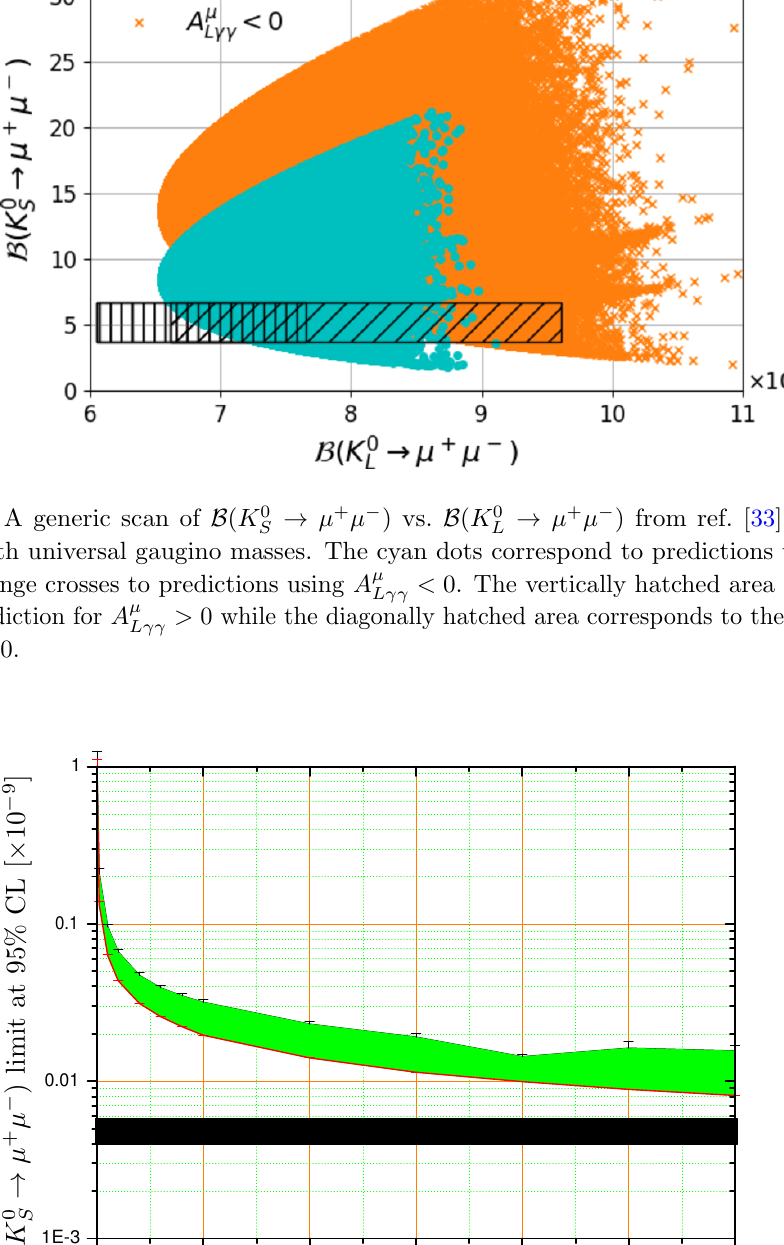
( K 0 (cid:22) + (cid:22) (cid:0) ) from LHCb including upgrades, against the S ! B 300fb (cid:0) 1 . (cid:25)